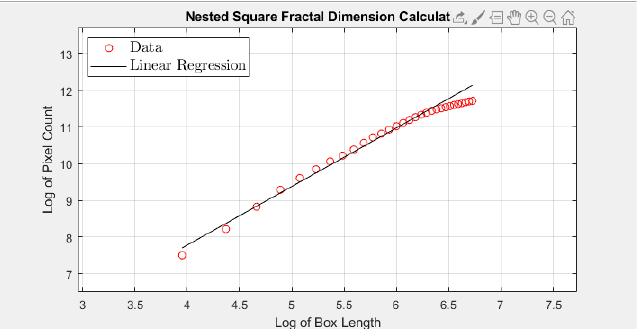
Figure 6. A graph produced by using the nested square method. The slope in this graph is 1.6 which corresponds to the fractal dimension of the measured aerosol . When the line of best fit is lined up with the data points, the fractal dimension pro- duced is acceptable. However, sometimes the mass of the aggregates is distributed une- venly around the center, causing an abrupt change in the slope. Therefore, the points on the plot corresponding to the largest nested squares may need to be excluded. They tend to level out which skews the line of best fit and by extension the fractal dimension as shown in Figure 6 [42], so the only the linear portion must be fit. Overall, the method of nested squares requires reducing the number of data point for the purposes of curve fit- ting to avoid the truncation effect.